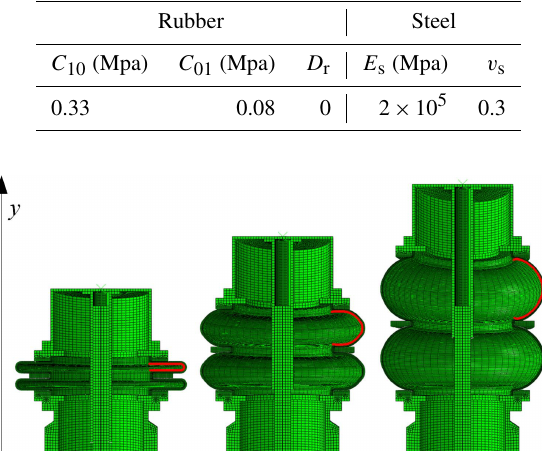
the bottom end caps and the guide column is RP-2. The top and bottom end caps and the snap ring are tied to the outer side of the rubber bellows. The surface-to-surface contacts are established among guide column, guide sleeve, end caps, snap ring and rubber